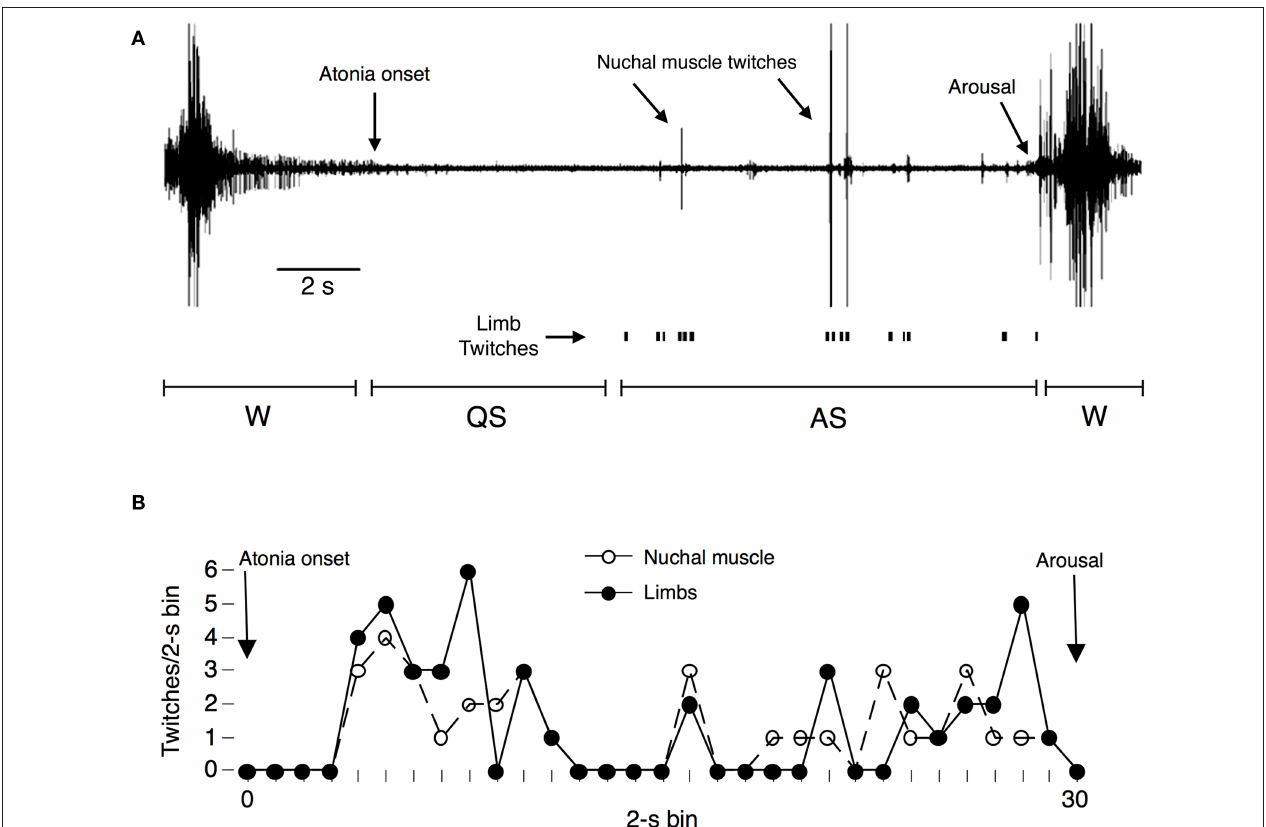
data from a single period of atonia in a P8 rat showing the number of twitches measured during successive 2-s bins. Electrographically scored nuchal muscle twitches (open circles) and visually scored limb twitches (filled circles) are shown separately and indicate temporally confined bursts of twitching during active sleep. Adapted from Seelke and Blumberg